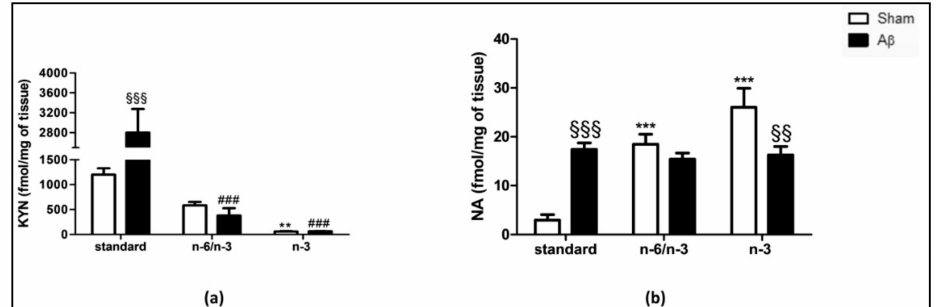
Figure 5. Effects of standard, n-6/n-3 PUFA balanced and n-3 PUFA enriched diets on KYN and NA levels in A β -treated rats. Effect of standard, n-6/n-3 PUFA balanced and n-3 PUFA enriched diets on KYN ( a , SHAM standard n = 3, A β standard n = 4, SHAM n-6/n-3 n = 5, A β n-6/n-3 n = 3, SHAM n-3 n = 5, A β n-3 n = 3) and NA ( b , SHAM standard n = 4, A β standard n = 4, SHAM n-6/n-3 n = 6, A β n-6/n-3 n = 6, SHAM n-3 n = 4, A β n-3 n = 6) content in the hippocampus of rats 7 days after A β icv injection (A β , 4 µ M, black bar) or vehicle (sham, 5 µ L, white bar). Two-way ANOVA followed by Bonferroni multiple comparison test, §§ p < 0.01, §§§ p < 0.001 A β -treated rats fed, either, with n-6/n-3 balanced and n-3 PUFA enriched diets versus SHAM rats; ** p < 0.01, *** p < 0.001 SHAM rats fed with n-6/n-3 balanced and n-3 PUFA enriched diets versus SHAM standard diet; ### p < 0.01 A β -treated rats fed with n-6/n-3 balanced and n-3 PUFA enriched diets versus A β standard diet. Data were expressed as means ± mean standard error